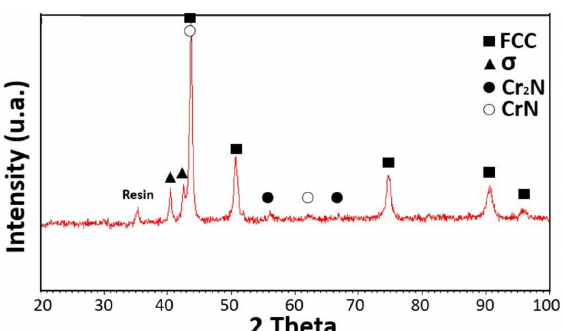
Figure 15. Diffraction pattern on a sample annealed at 1173 K for 100 h. Peaks are due to resin, FCC Cantor’s alloy (card number 00-033-0397), σ phase (card number 00-005-0708), Cr 2 N (card number 00-035-0803), CrN (card number 00-011-0065). Table 2. EDS semi-quantitative chemical compositions, in atomic %, of FCC matrix of cold-rolled samples. Relative uncertainty on data is less than 2% except for N (30%) and Mn (7%).